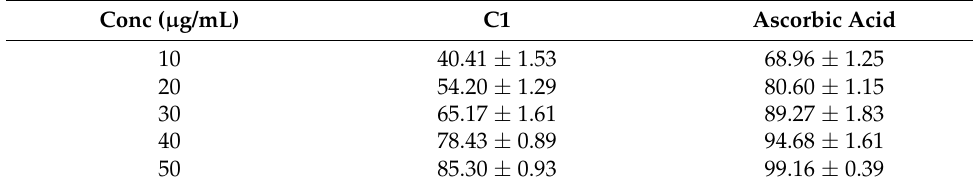
Table 6. ABTS radical scavenging activity of C1.